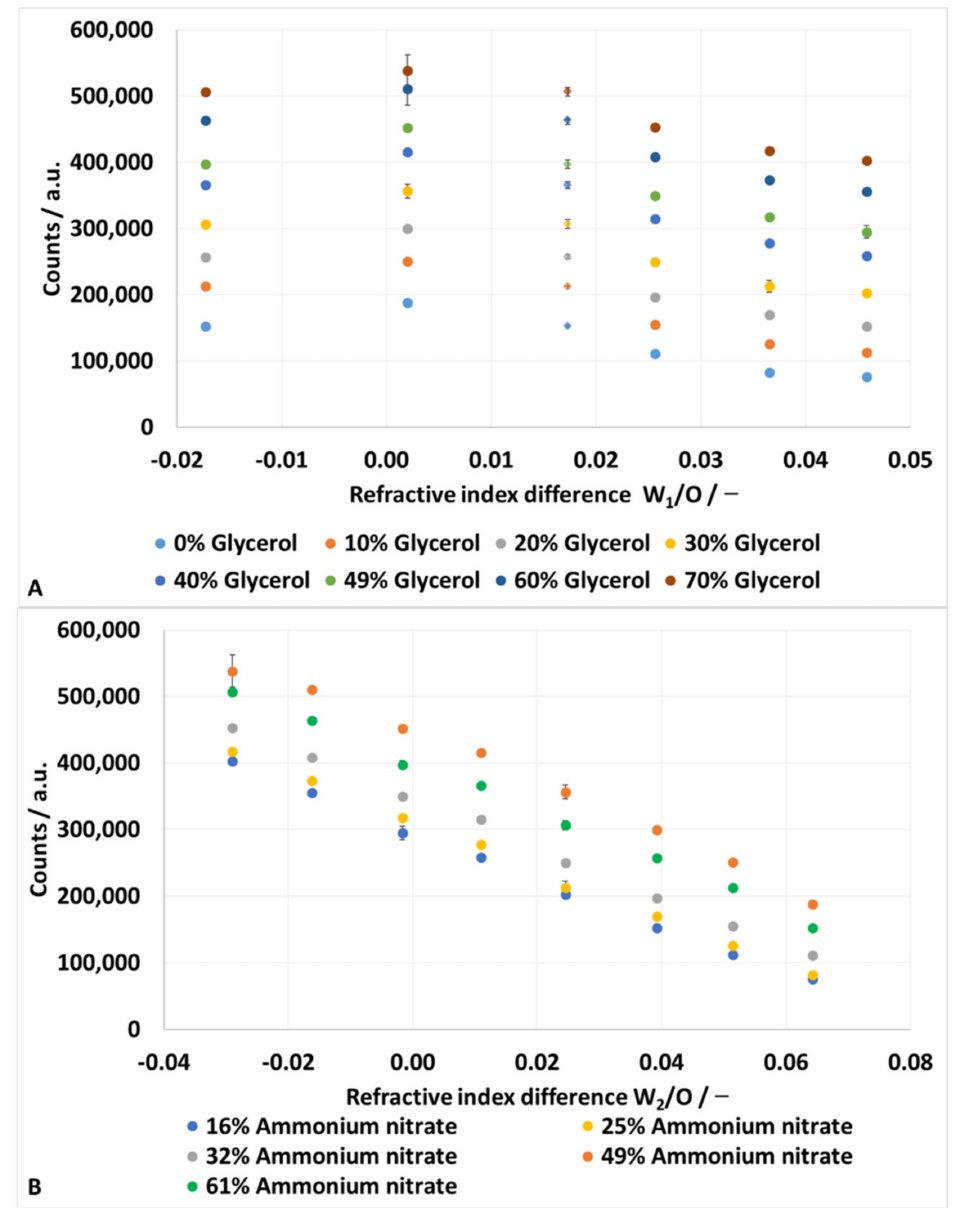
Figure 6. Results of the experiments presented as a function of refractive index differences between the oil phase and the inner water phase ( A ) and the outer water phase ( B